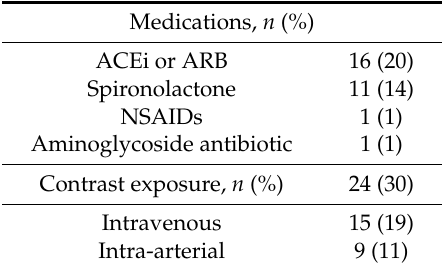
Table 4 highlights iatrogenic contributors to hyperkalemia. Of the 28 patients dialyzed with hyperkalemia, 13 (46%) were not given a low potassium diet and 3 (11%) were receiving either an ACEi, ARB or spironolactone; one (4%) received potassium supplements in addition to spironolactone. Further, of the 6 patients with serum potassium ≥ 6.0 mmol/L at HD initiation, 3 were not provided with low potassium diets, and 2 received potassium supplements or potassium sparing